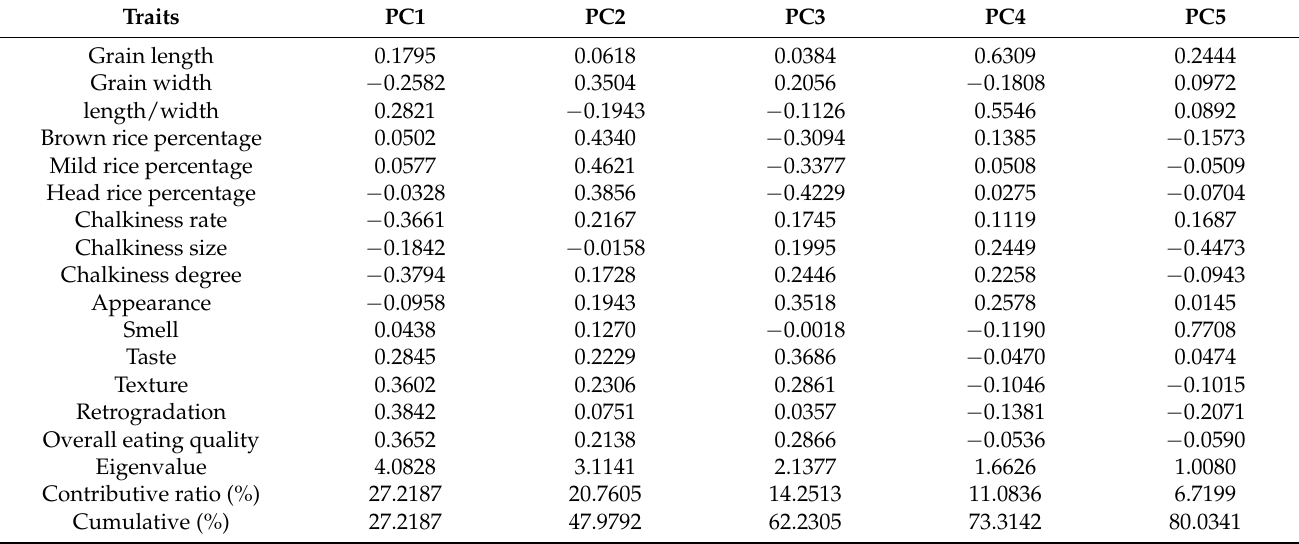
Table 2. Eigenvalue and contribution of each comprehensive index and loading matrix of each com- ponent for qualities of hybrid indica rice.